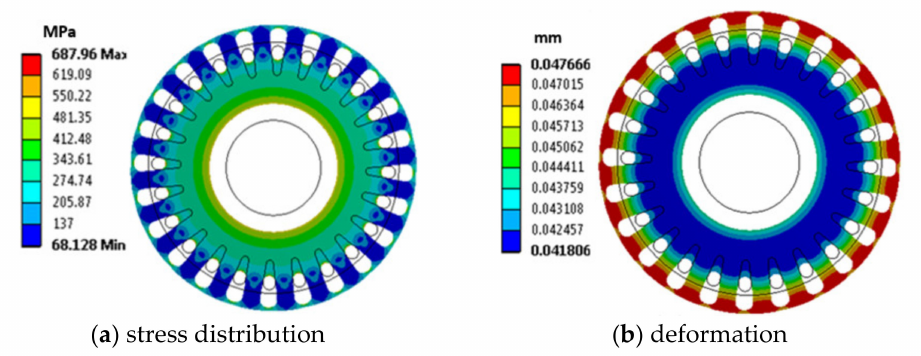
Figure 9. Stress distribution and deformation in HXT780T lamination including centrifugal and copper bar load.